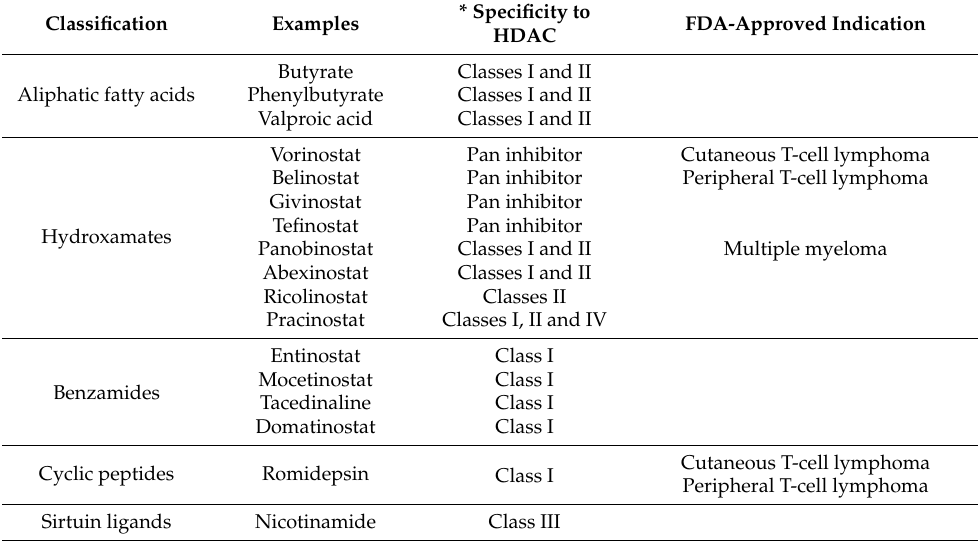
Table 2. Drug Approvals and Examples of HDAC